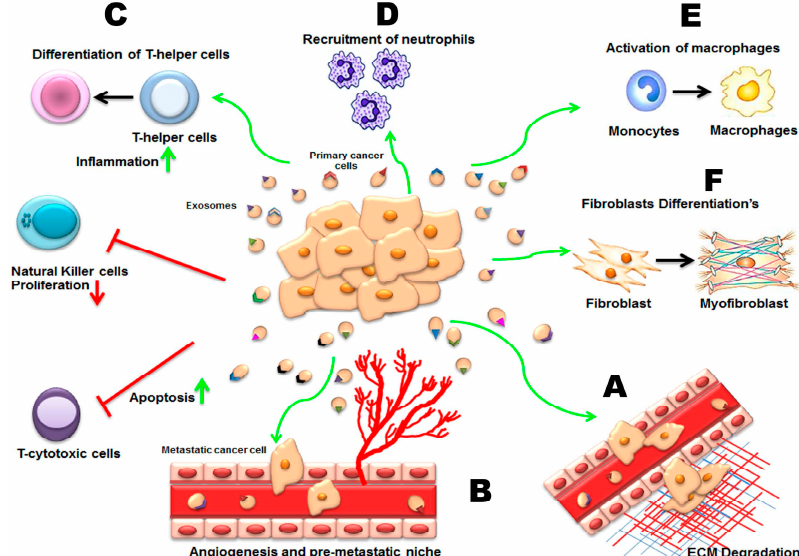
Figure 3. Biological functions of exosomes in tumorigenesis. Exosomes released from tumor cells affect the local tumor microenvironment and are critically involved in tumor initiation, growth, progression, and metastasis by transferring oncogenic proteins and nucleic acids. ( A ) Exosomes travel to distant sites to promote generation of the pre-metastatic niche; ( B ) Angiogenesis is increased and endothelial and stromal cell differentiation is induced, leading to a pro-tumor environment; ( C ) Exosomes have immunosuppressive effects and assist cancers in immune evasion. Cytotoxic T cells are induced to apoptosis, while natural killer cell proliferation is impaired, and T-helper cells differentiate toward a T-regulatory cell phenotype; ( D ) Bone marrow-derived cells are recruited to tumor and pre-tumor tissue where they contribute to cancer development; ( E ) Exosomes are also responsible for the recruitment and activation of tumor-associated macrophages (TAMs) by promoting their polarization. TAMs support diverse phenotypes within the primary tumor, including growth, angiogenesis, and invasion, by secreting a plethora of pro-tumorigenic proteases, cytokines, and growth factors; ( F ) Exosomes can functionally modify fibroblasts by reprogramming these cells to cancer-associated fibroblasts (CAFs), which exhibit myofibroblastic differentiation. Red arrows indicates a negative contribution or repression and green arrows indicate an activation or positive function.